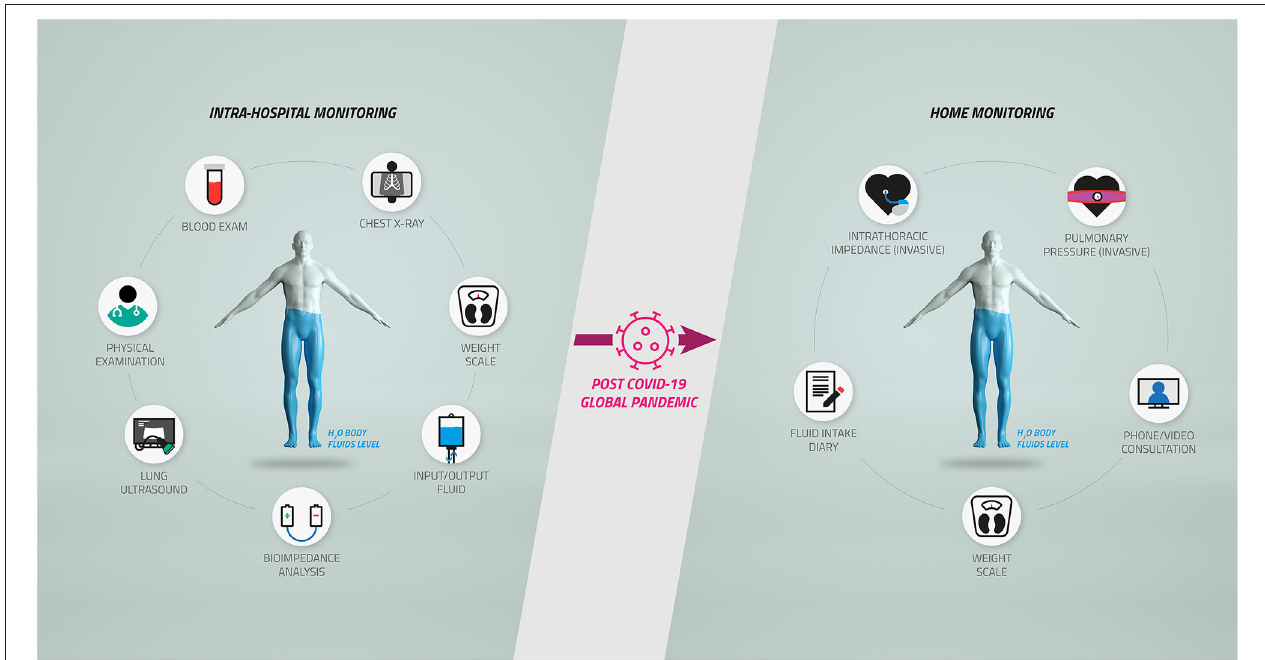
FIGURE 1 | Body fluid management in chronic heart failure and cardiorenal patients after the coronavirus disease 2019 (COVID-19) pandemic. The complex workflow for the diagnosis and monitoring of body fluids of chronic heart failure and cardiorenal patients inside the hospitals (Left) has been restricted by the COVID-19 pandemic, causing a potentially relevant shift toward home monitoring protocols (Right)